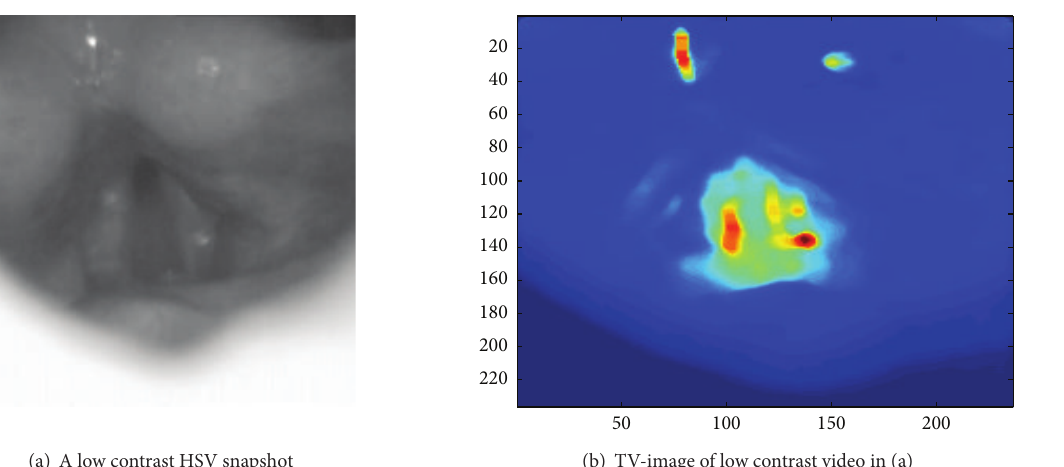
Figure 9: A low contrast HSV and its